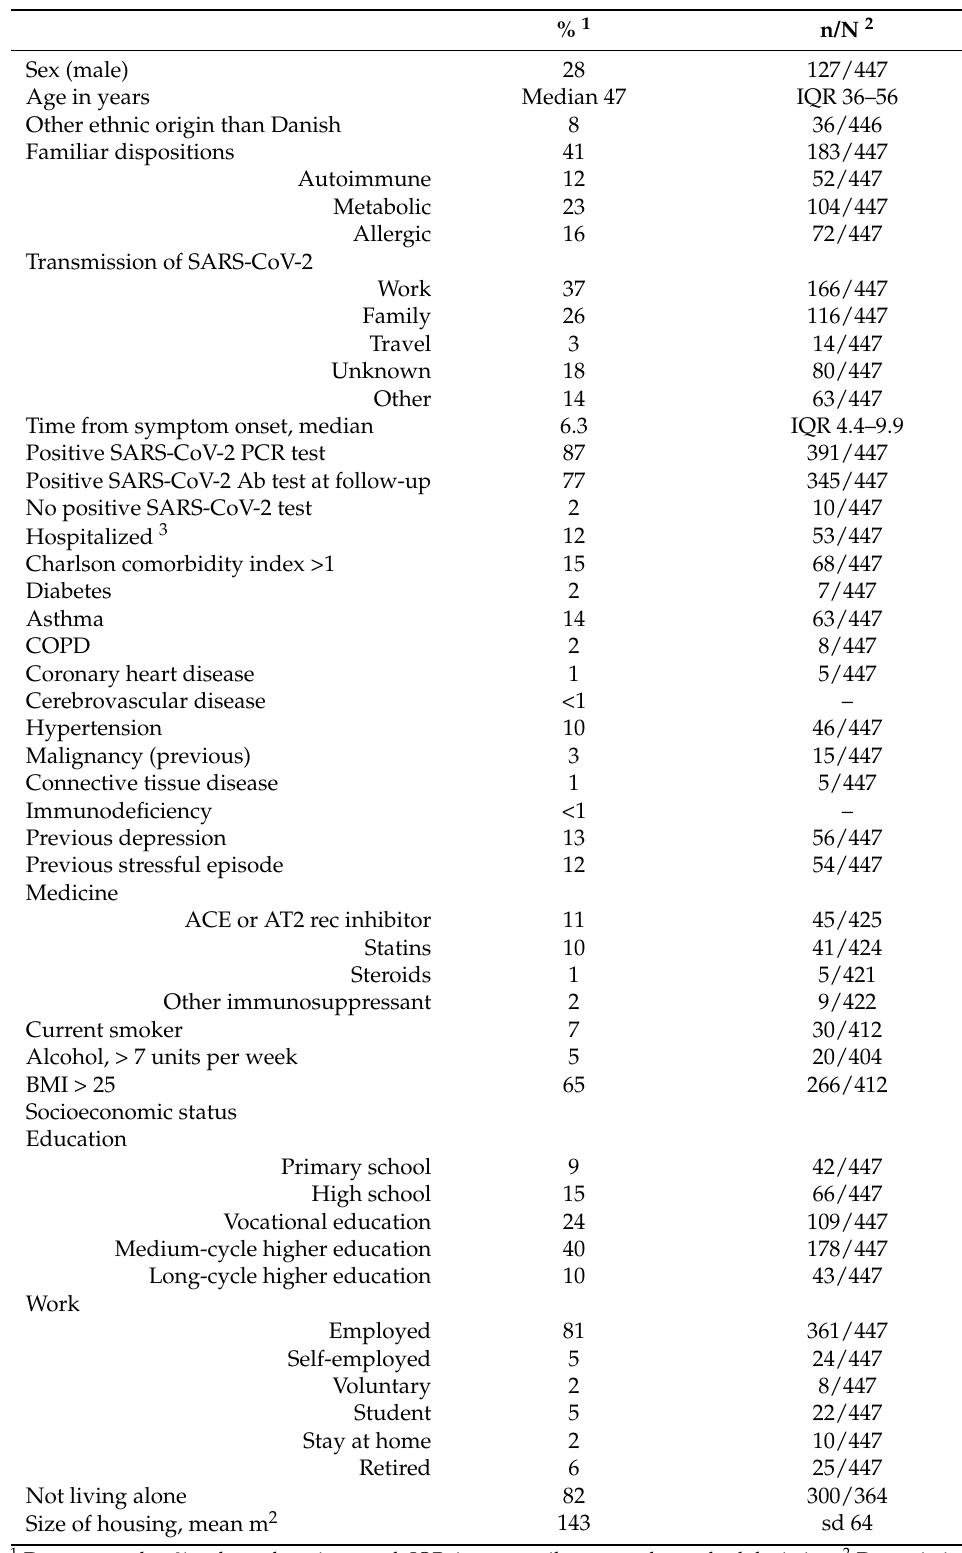
Table 1. Characteristics of patients in a Post COVID